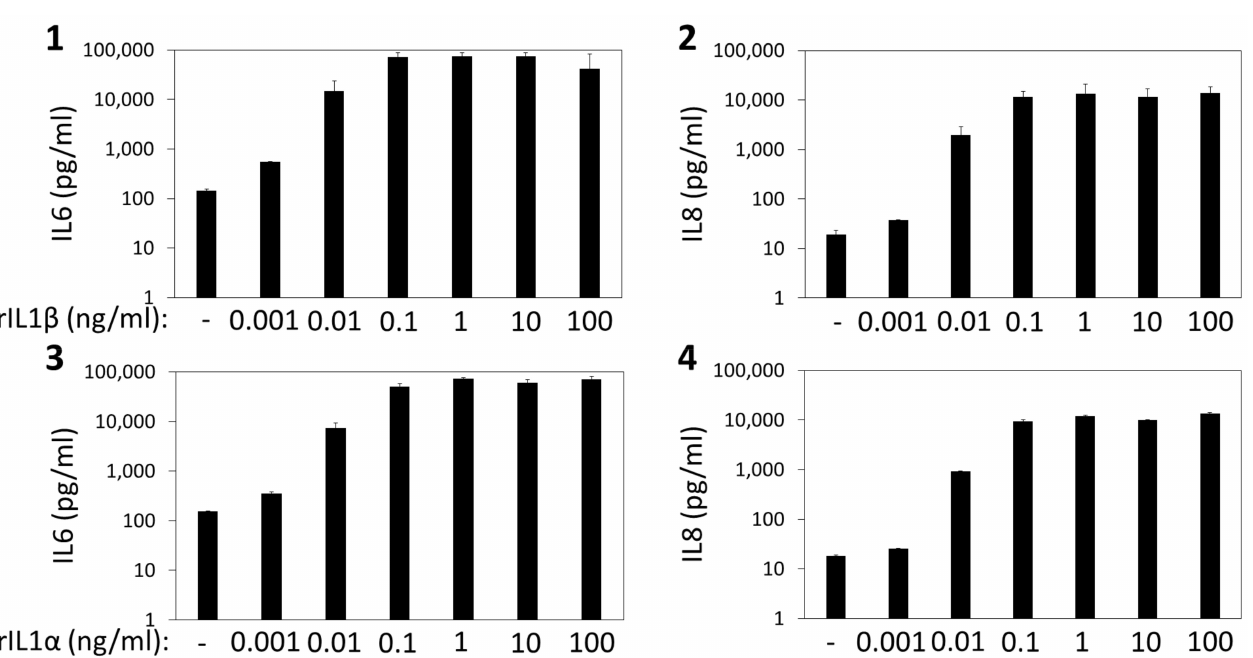
Figure A1. Dose response to recombinant IL1 β and IL1 α in human bronchial fibroblasts. Primary culture HBF were treated for 24 h with recombinant (r)IL1 β ( 1 , 2 ) or rIL1 α ( 3 , 4 ) using concentrations indicated in the figure. HBF supernatants were collected and release of IL6 and IL8 was analyzed via ELISA ( n = 2 technical replicates).